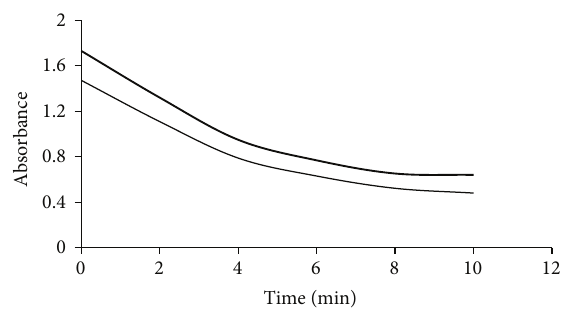
Figure 2: Time resolved profile of oxidation reaction of methylene blue in the presence (thin line) and absence (thick line) of Ag NPs as catalyst.